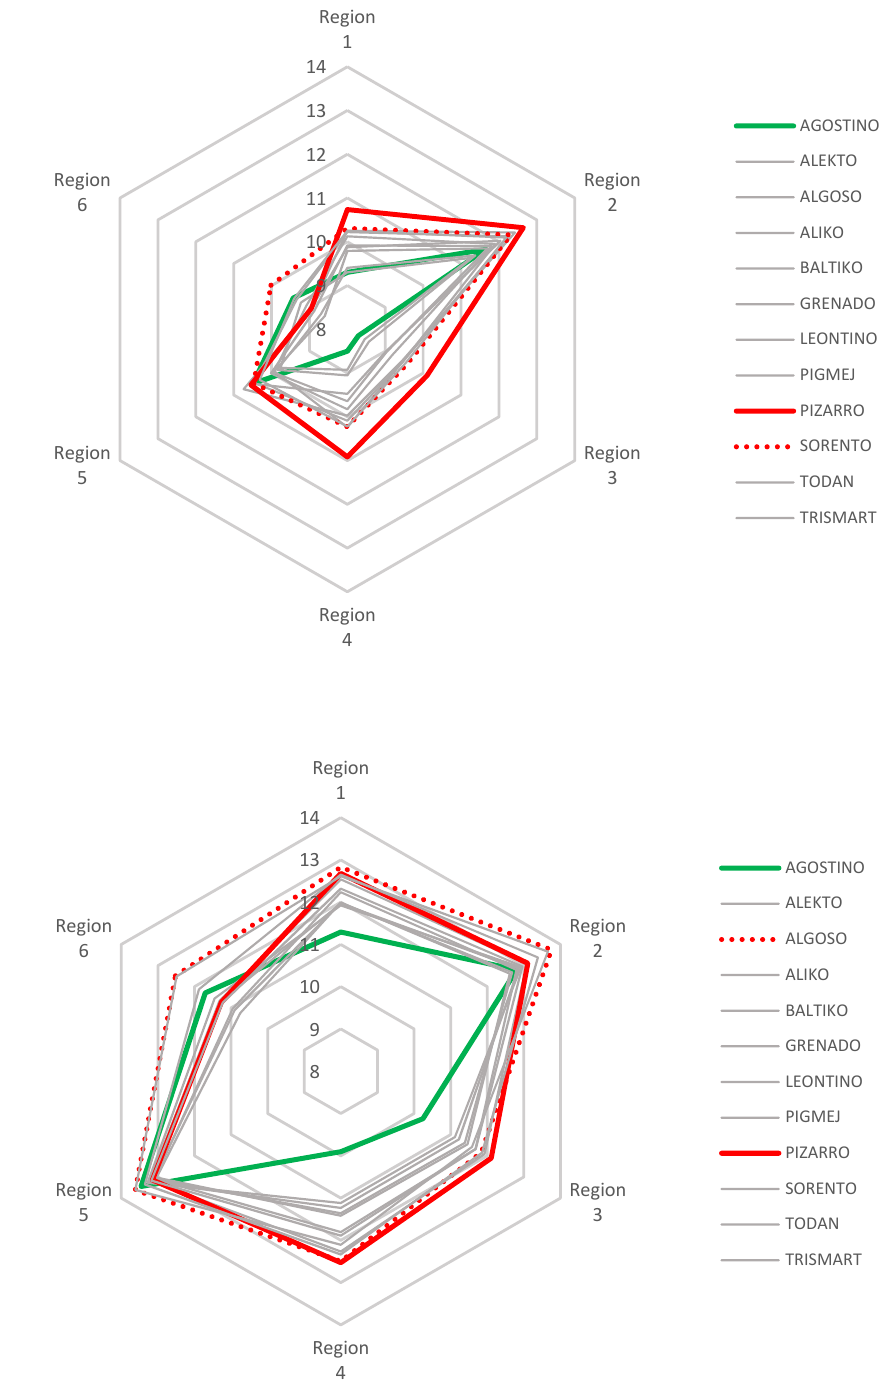
Figure 4. Adaptive response of cultivars to environmental conditions across 6 regions for the moderate-input crop management MIM ( a ), and for the high-input management HIM ( b ).